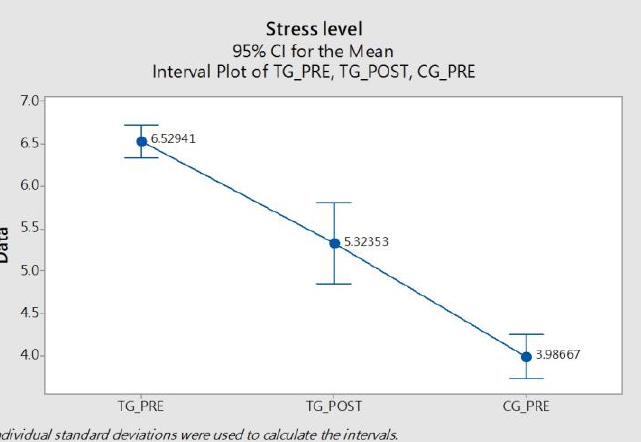
Figure 10. Interval plot for Stress level of TG_PRE, TG_POST, and CG.